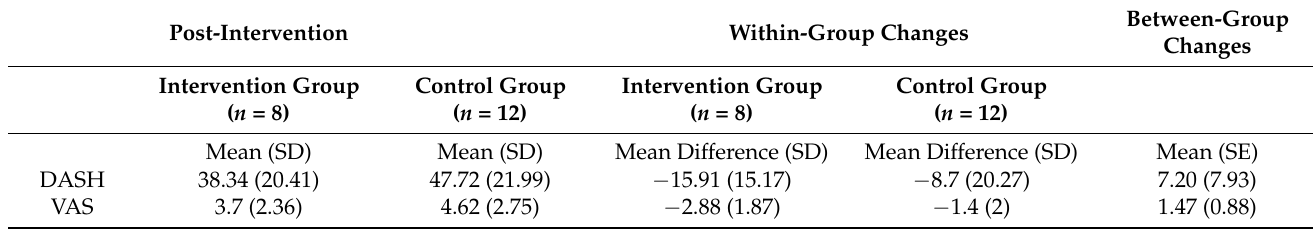
Table 2. Post-intervention results of primary outcome measures including within-group and between- group changes.